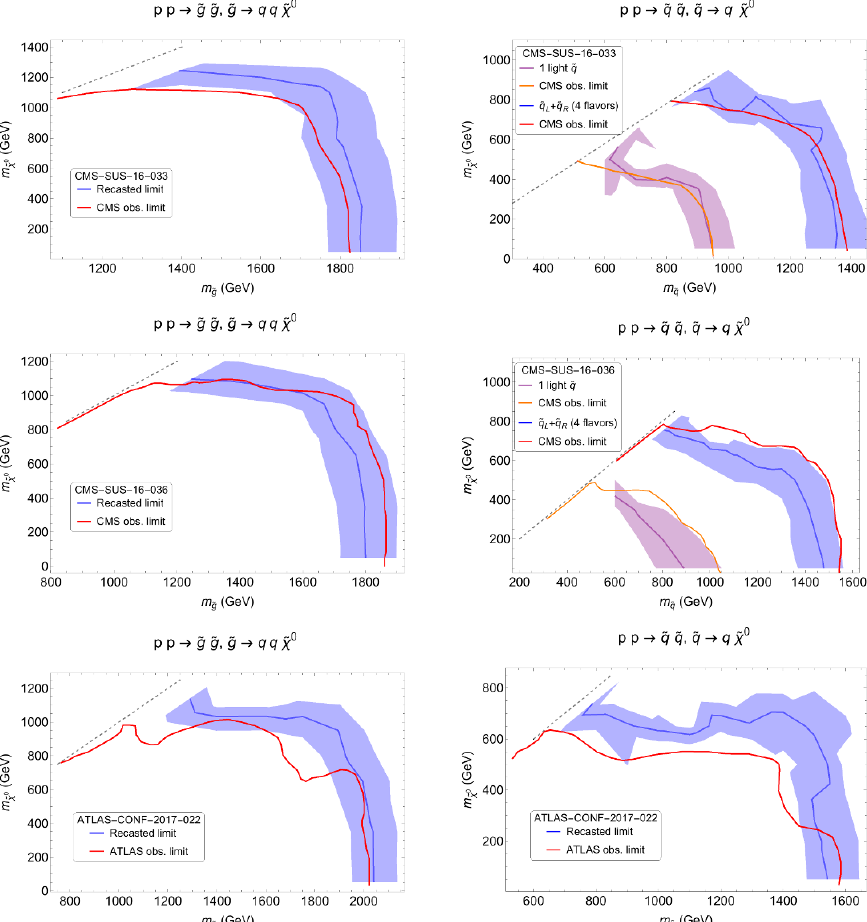
Figure 11 . The validation plots for [13] ((cid:12)rst row), [12] (second row) and [14] (third row), for the ~ g ! qq ~ (cid:31) 0 (left) and ~ q ! q(cid:31) 0 (right) simpli(cid:12)ed models. The blue and purple lines denote the 95% C.L. limit calculated using the likelihood analysis described in appendix A. The shaded regions denote the same limit as the solid line with 50% error included in our signal strength in each direction (to take the possible recasting errors into account). The red and orange lines are the o(cid:14)cial observed limits.